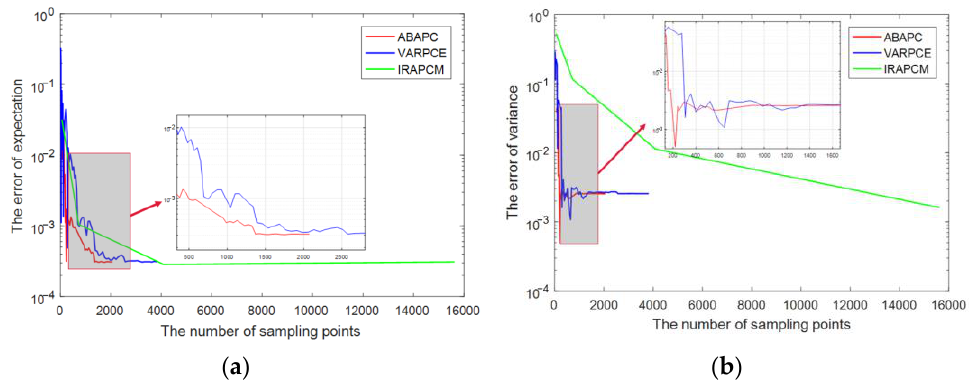
e r er Figure 3. Convergence of er µ and er σ for case 2 using different methods: ( a ) relative error of   for case 2 using different methods: ( a ) relative error of Figure 3. Convergence of and expectations, and ( b ) relative error of variances. expectations, and ( b ) relative error of variances.